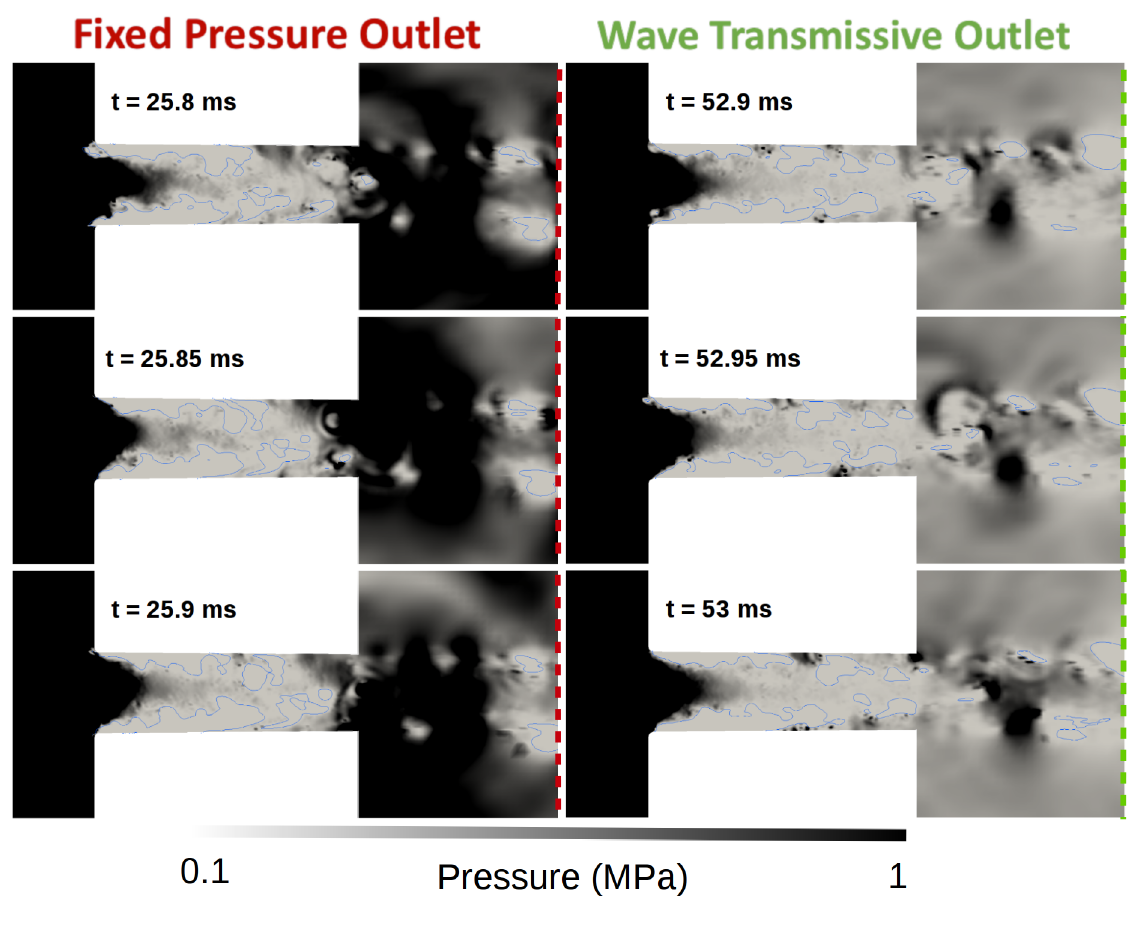
Figure 14. Left : Pressure distribution in the nozzle region, fixed pressure outlet boundary condition, MUSCL, p dif f = 8.5 MPa. Right : Pressure distribution in the nozzle region, Wave transmissive outlet boundary condition, MUSCL, p dif f = 8.5 MPa. The blue contour which indicates a vapour fraction of